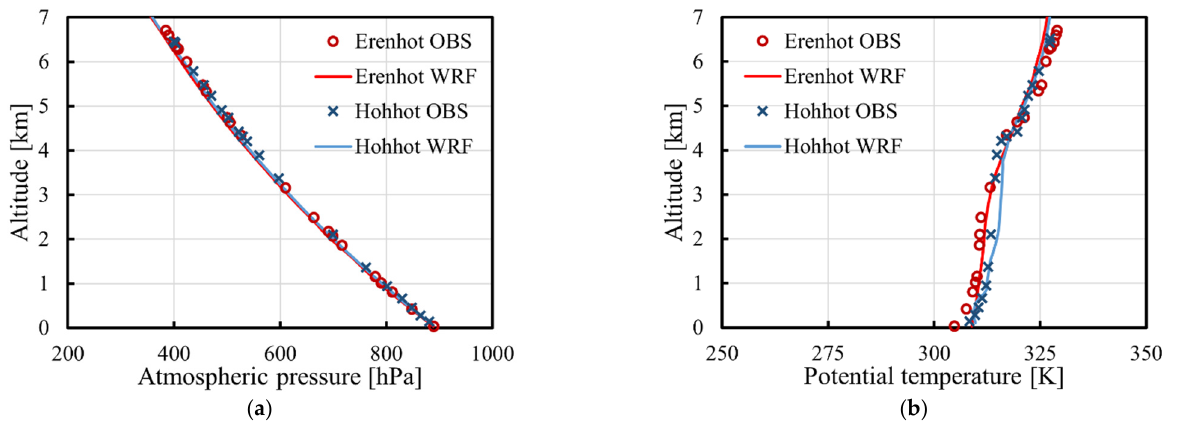
Figure 12. Profiles of ( a ) atmospheric pressure and ( b ) potential temperature above the main landing area from WRF and upper-atmosphere sounding data at 12:00 LST on 25 June 2013.